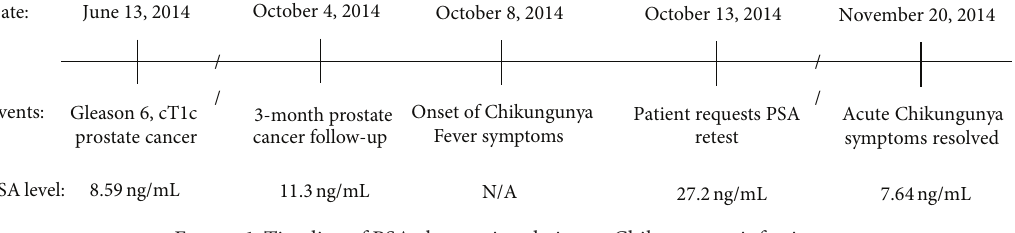
Figure 1: Timeline of PSA changes in relation to Chikungunya